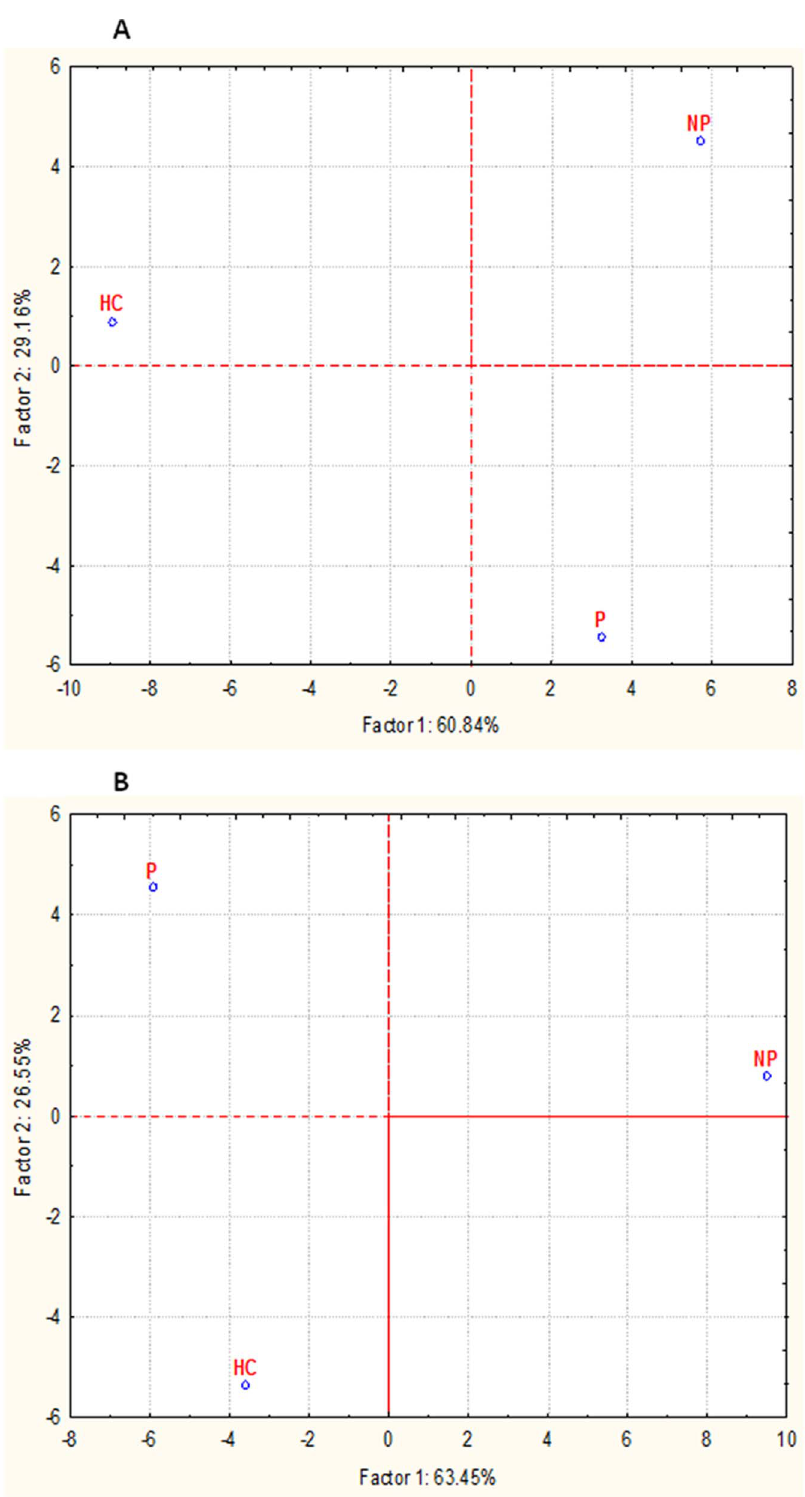
Figure 7. Principal component analysis (PCA) of volatile organic metabolites found in feces of subjects. Score plots of the two principal components (PC) after principal component analysis (PCA) of volatile organic metabolites of the fecal (A) and urine (B) samples of immunoglobulin A nephropathy (IgAN) non progressor (NP) and progressor (P) patients, and healthy controls (HC).